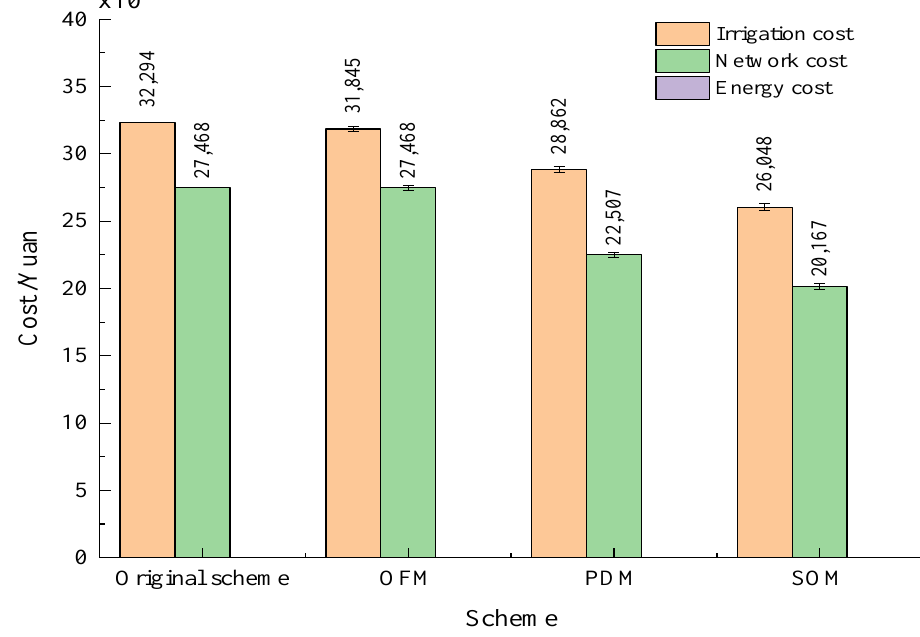
Figure 9. Irrigation cost, network cost and energy cost of the original scheme, OFM, PDM, SOM.